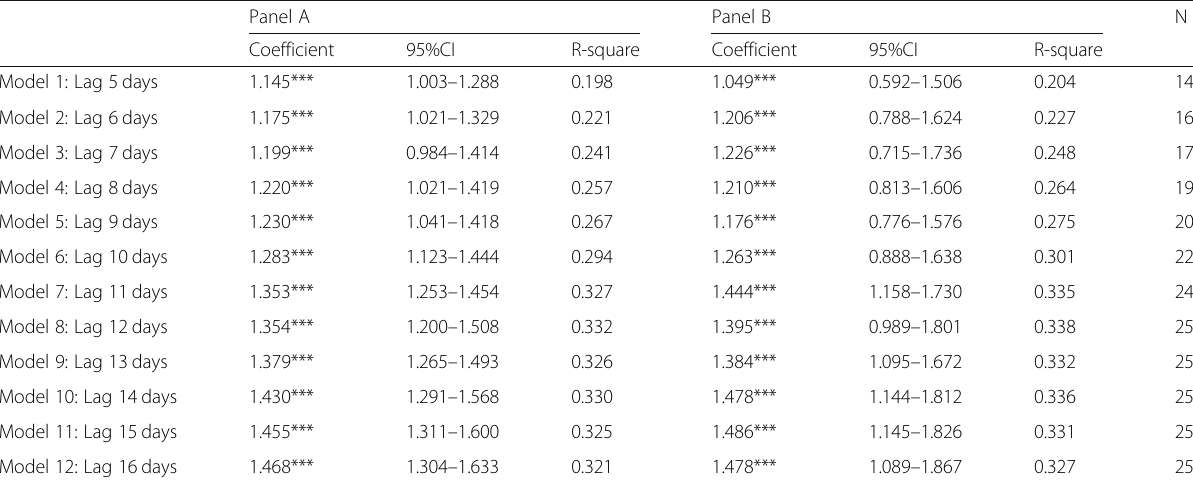
Table 1 Population mobility and proportion of confirmed COVID-19 cases: based on RE model Panel A Panel B Coefficient 95%CI